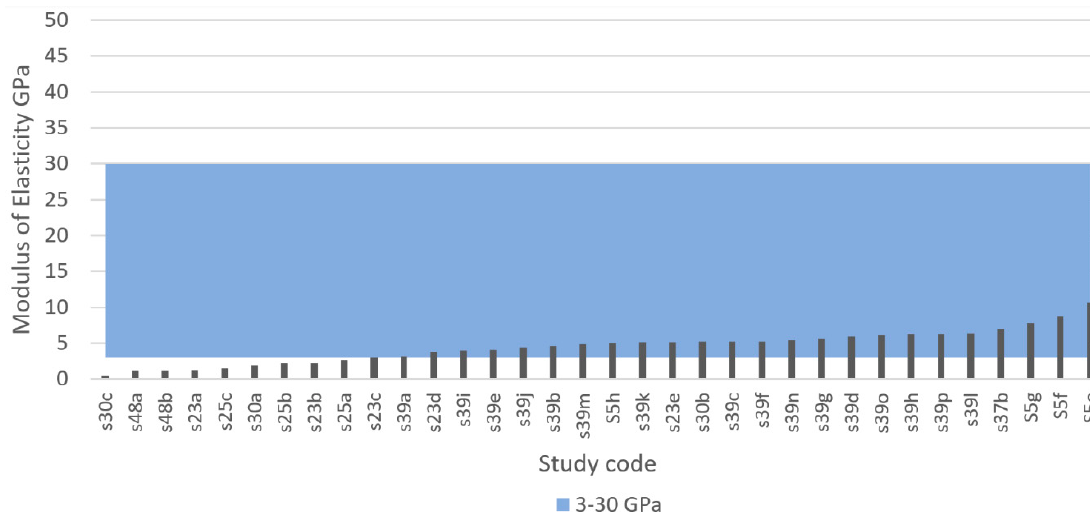
Figure 11. Elastic modulus of porous metamaterials based on triply periodic minimal surfaces (TPMS) compared with the Ideal Quality Attribute (IQA) target zone.